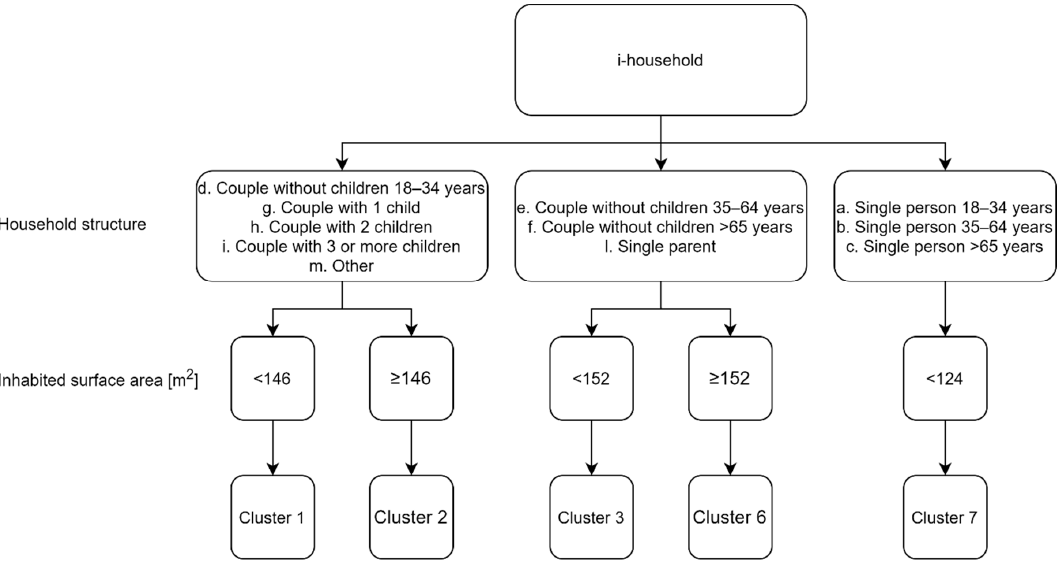
Figure 5. Monitored households clustering. Table 4. Clusters subdivision of the monitored Italian households.